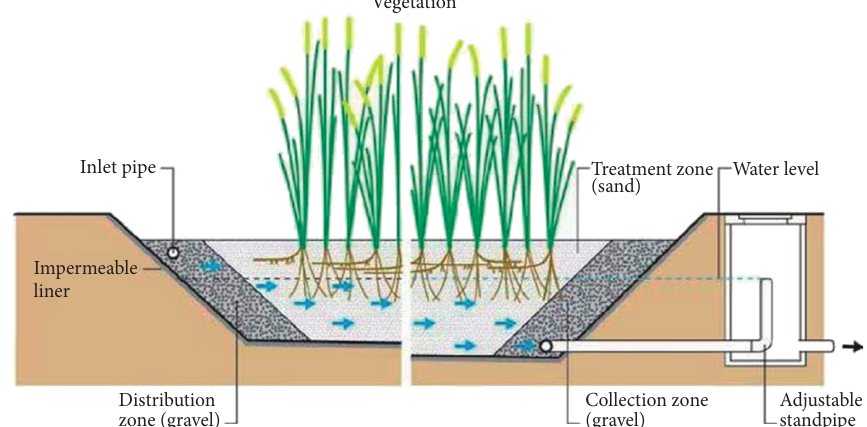
Figure 2: Schematic cross section of a horizontal-flow constructed wetland (HFCW) (source: